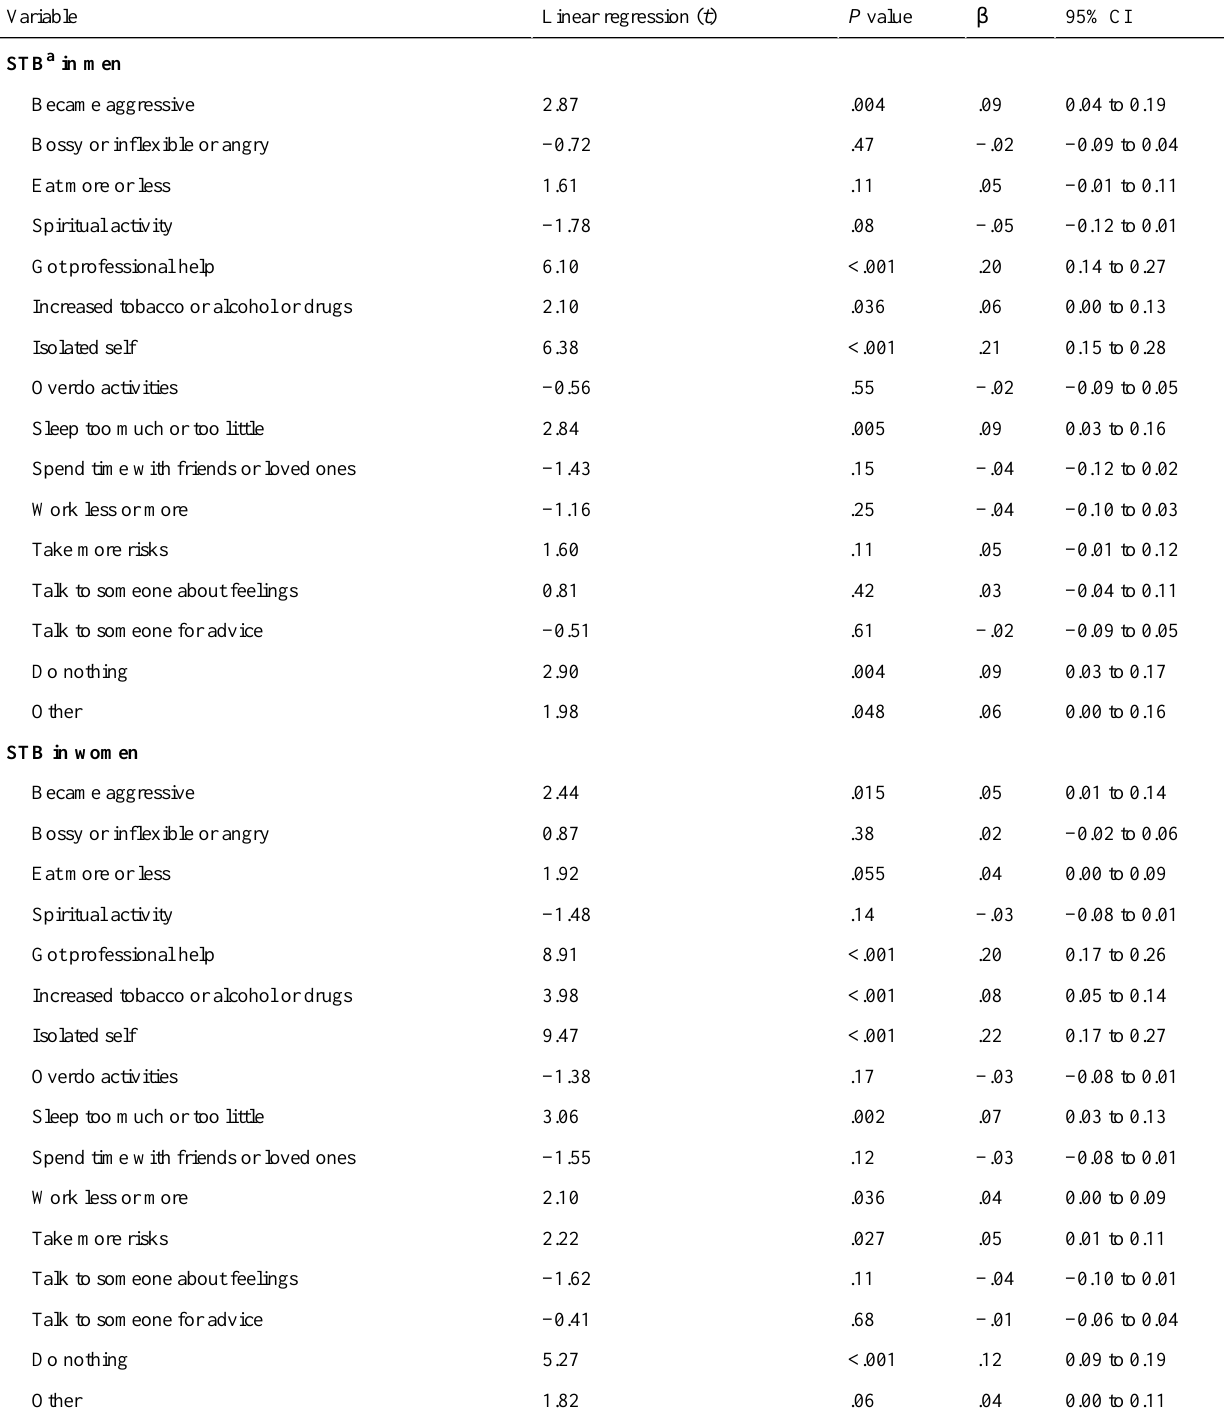
Table 5. Linear regression of coping responses after experiencing a stressful transitional life event as predictors of suicidal thoughts and behaviors by